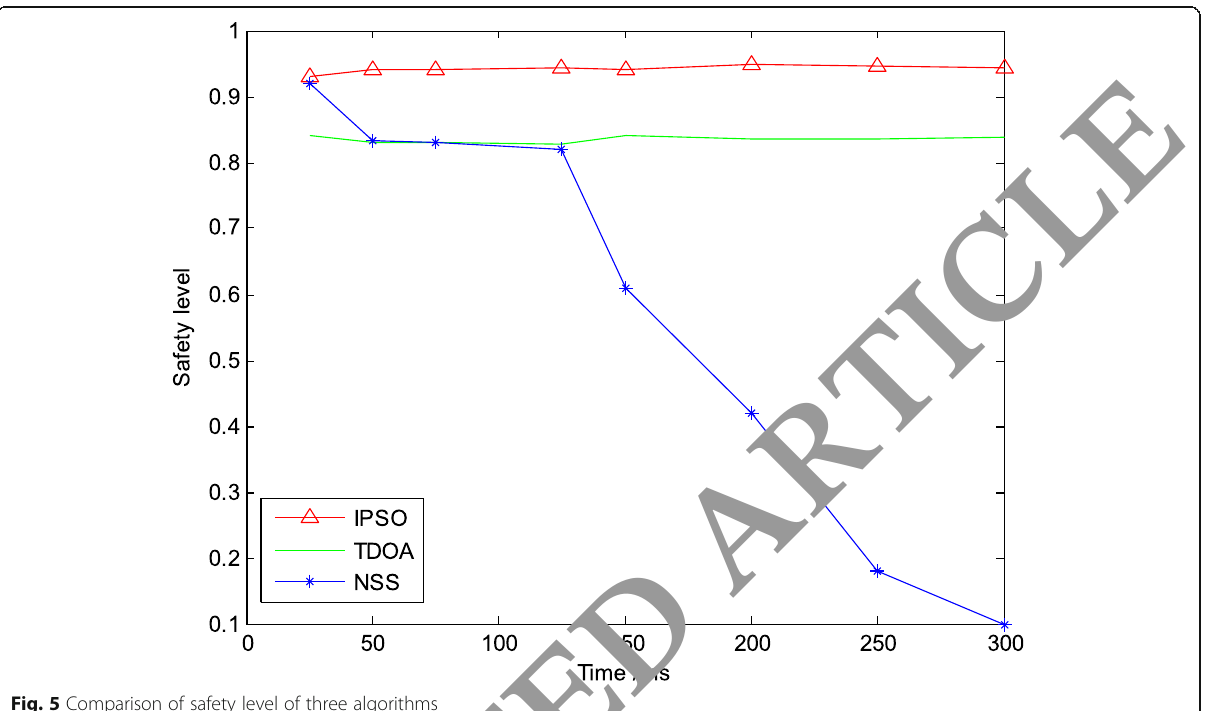
Fig. 5 Comparison of safety level of three algorithms